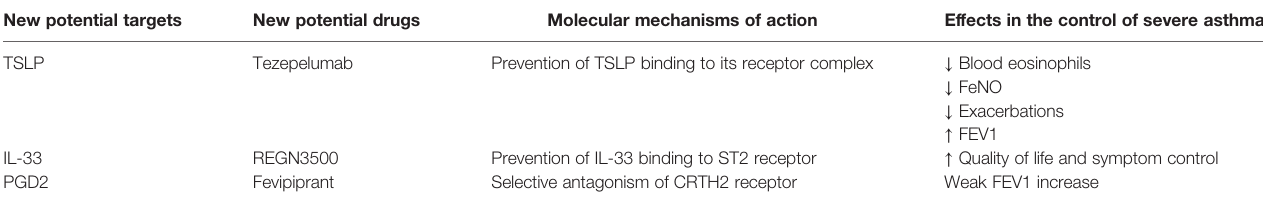
TABLE 2 | New potential targets of emerging anti-asthma